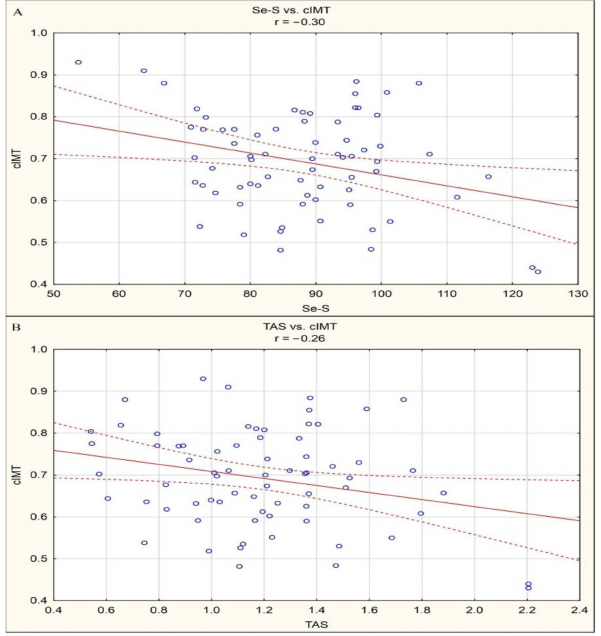
Figure 1. ( a ) Statistically significant correlations between Se-S and cIMT (r = − 0.30, p < 0.05). ( b ) Statistically significant correlations between TAS and cIMT (r = − 0.26, p < 0.05). Table 3. Results of regression analysis in the studied group of patients with arterial hypertension: model estimation for the dependent variable cIMT